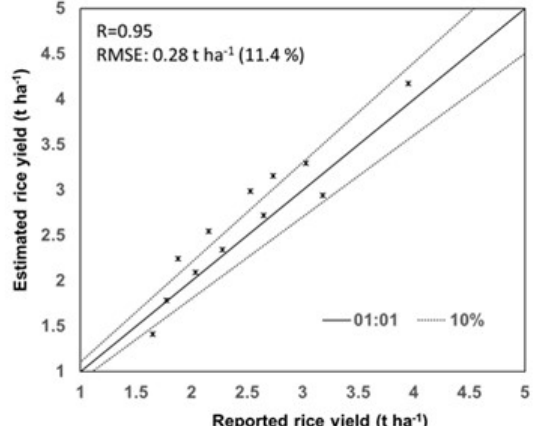
Fig 6. Comparison of state level rice yield estimated from the pixel model with the reported yield The absolute difference was lowest in India (8 %) followed by Sri Lanka (-11 %) and maximum in Nepal (35 %) (Fig 7).